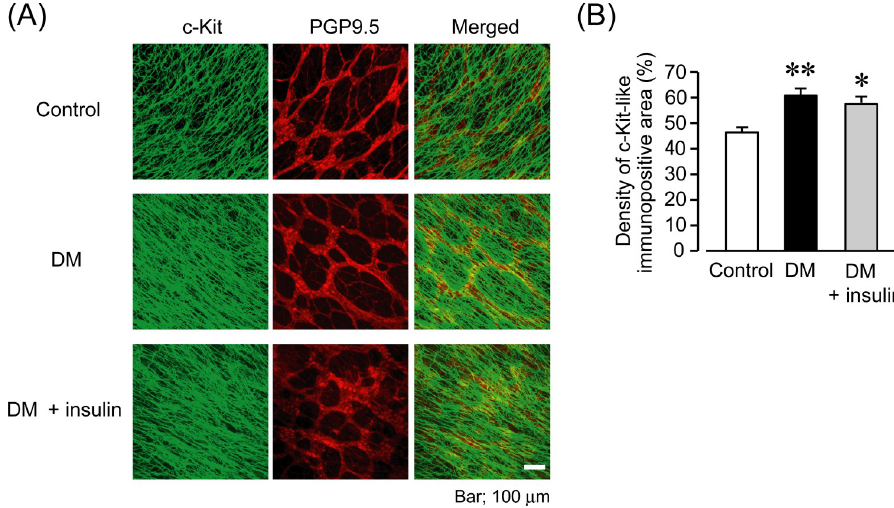
Fig 4. Hyperglycemia in the early stages of diabetes increases c-Kit-positive interstitial cells of Cajal. (A) Representative results of immunostaining for c-Kit (interstitial cells of Cajal marker; green) and PGP9.5 (neuron marker; red) in whole-mount preparations of gastric muscularis obtained from control, DM and DM + insulin mice at 2–4 weeks after STZ administration. Scale bar, 100 μ m. (B) Quantification of the density of the c-Kit-positive area. Each column shows the mean ± SEM (n = 6, 5, 4). � P < 0.05, �� P < 0.01; significantly different from control.